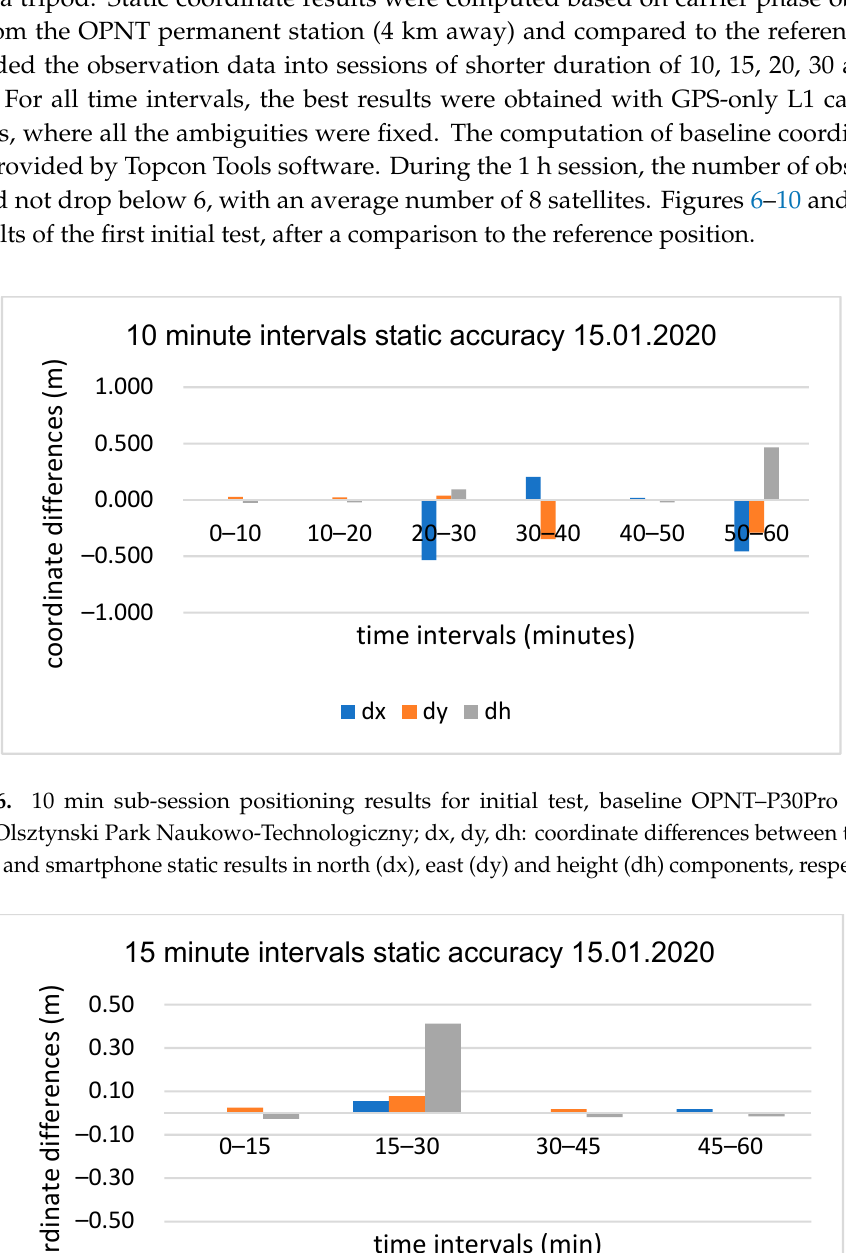
Figure 8. 20 min sub-session positioning results for initial test, baseline OPNT–P30Pro (4 km).